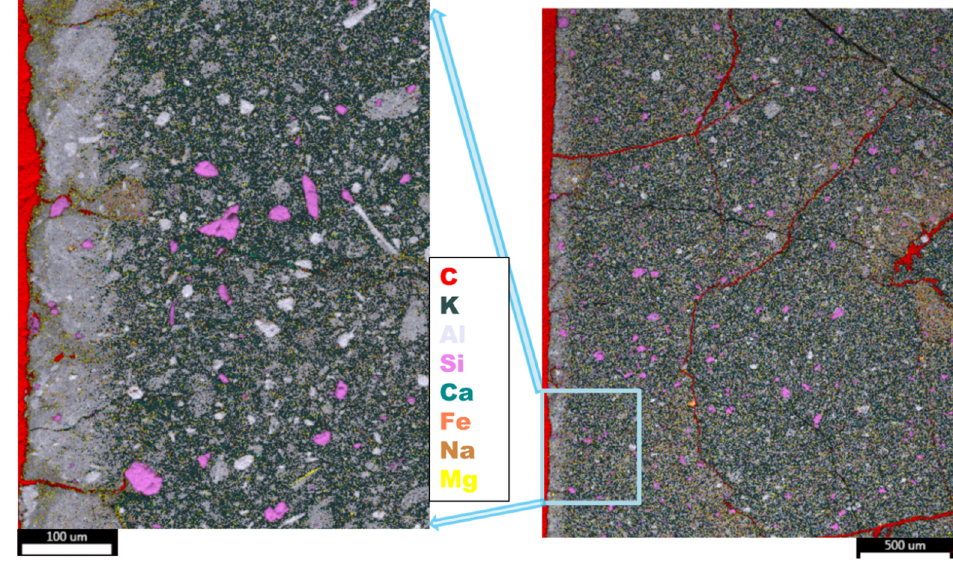
Figure 9. SEM ‐ EDS elemental mapping of a cross section after the exposure to pure water. The geopolymer ‐ water interface is on the left side of the